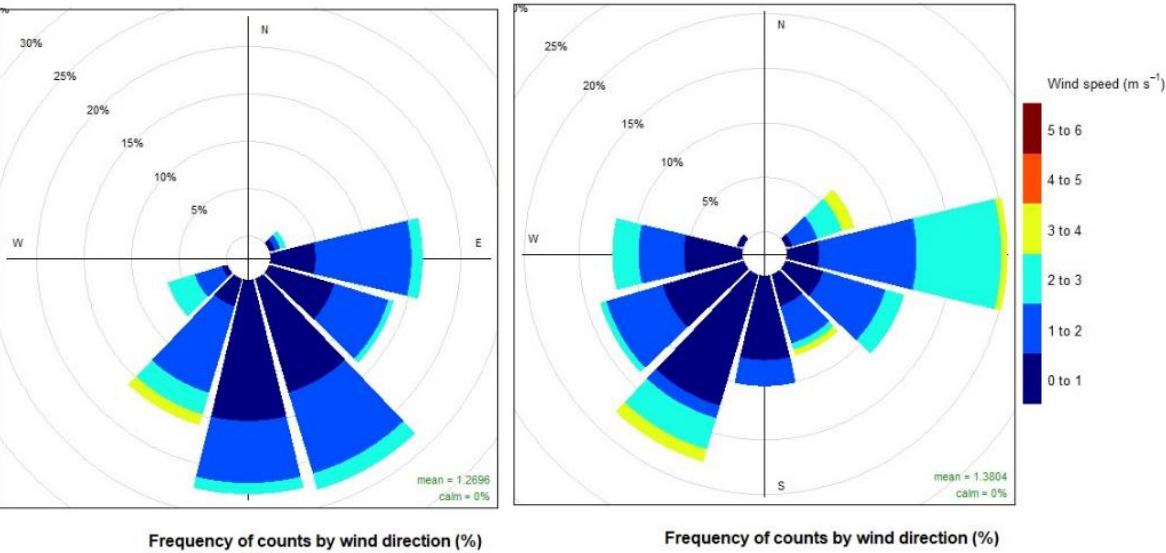
Figure 5. Wind rose values for the prevailing winds at the three-arm intersection ( left ) and round- about ( right ).